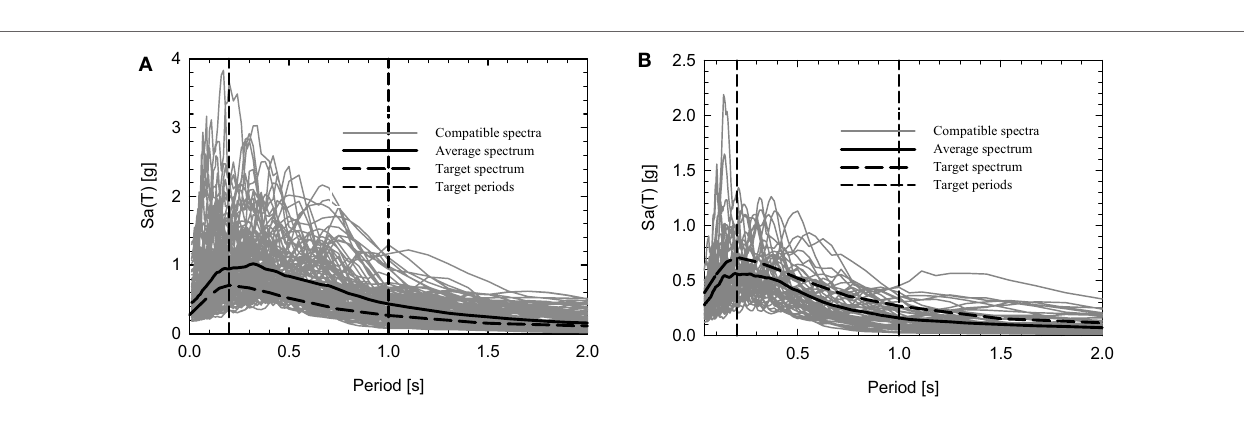
FigUre 9 | Mean deviation matching with uniform hazard spectrum as target spectrum, for the (a) Peer database and (B) esMD